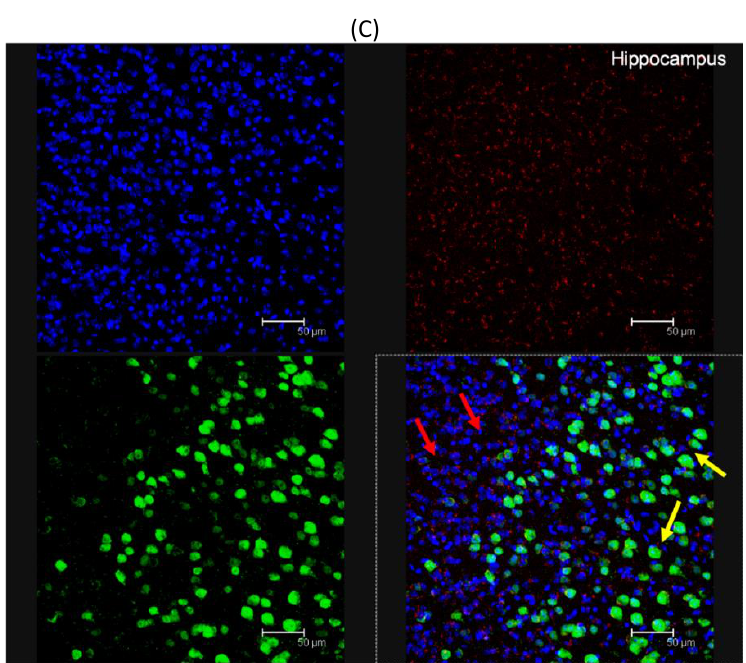
Figure 5. ( A ) Fluorescent microscopy analysis of Ang–2-NP brain distribution: cross section of the dentate gyrus, cortex, and hippocampus stained with DAPI (blue channel), Cy5- labeled Ang–2-NPs (red channel), and NEUN (green channel). ( B ) Magnified analysis of the dentate gyrus. ( C ) Magnified analysis of hippocampus. In both images ( B , C ), colocalization with (red arrows) NEUN negative stained cells and colocalization with neurons (yellow arrows) are identified. All images are representative of the average analysis, and scale bars in ( A – C ) are set at 50, 20, and 50 µm, respectively.